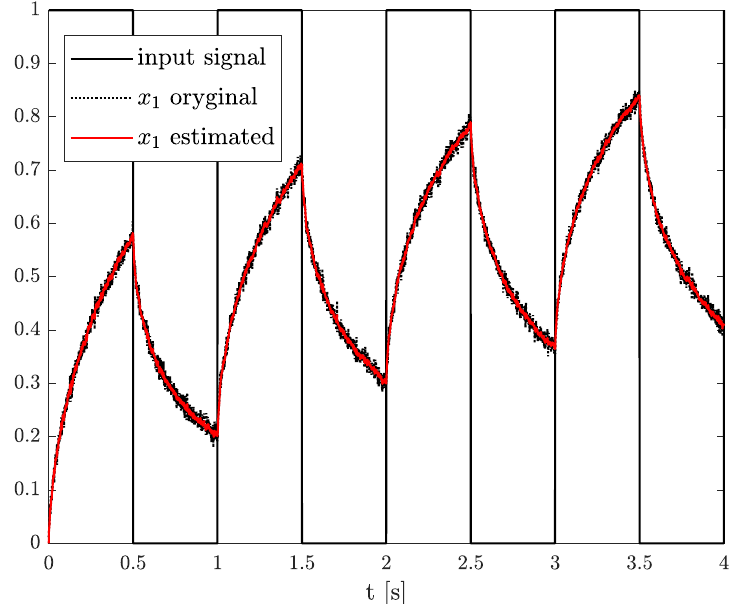
Figure 8. Original and estimated state variables from Example 2.